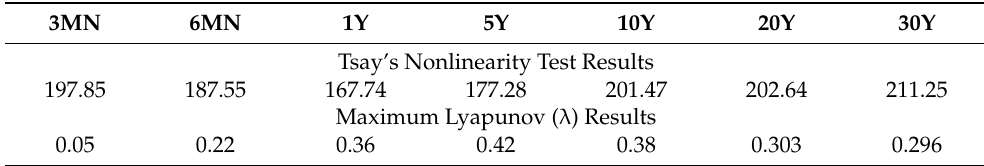
Table 3. Lyapunov * and Tsay Tests.